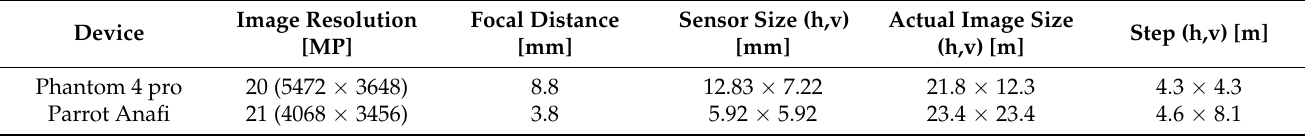
Table 4. Characteristics of the UAV devices used in the case